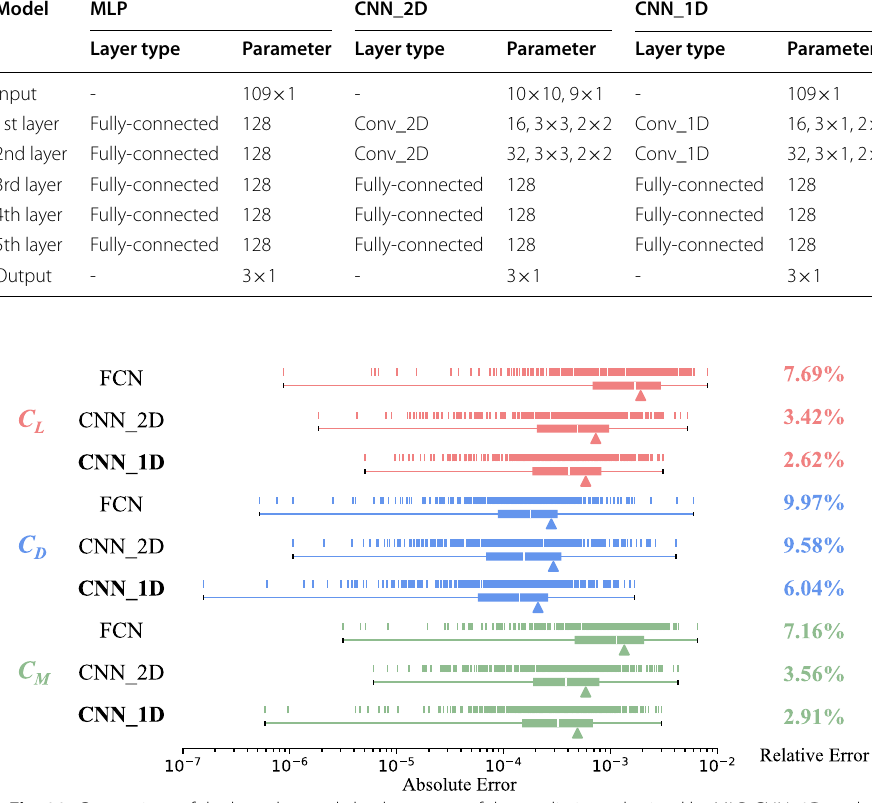
Fig. 22 Comparison of the box plots and absolute errors of the predictions obtained by MLP, CNN_2D, and